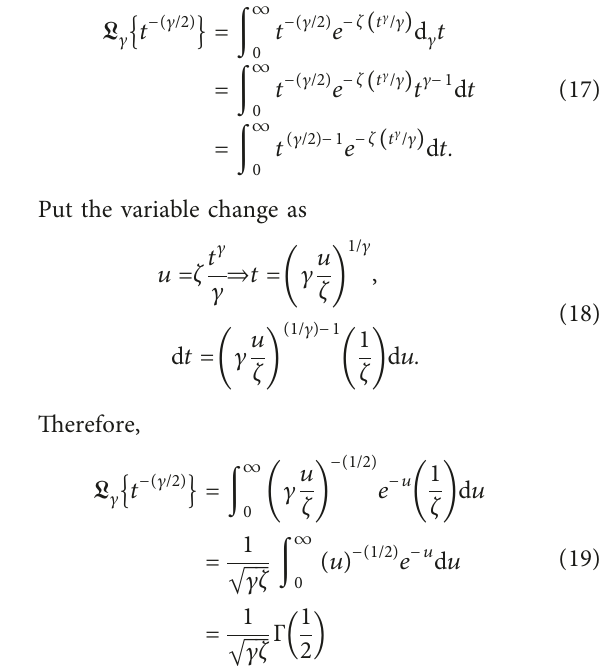
Figure 1: Square wave